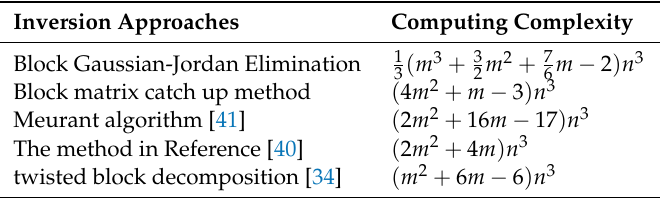
Table 1. Comparison of the computing